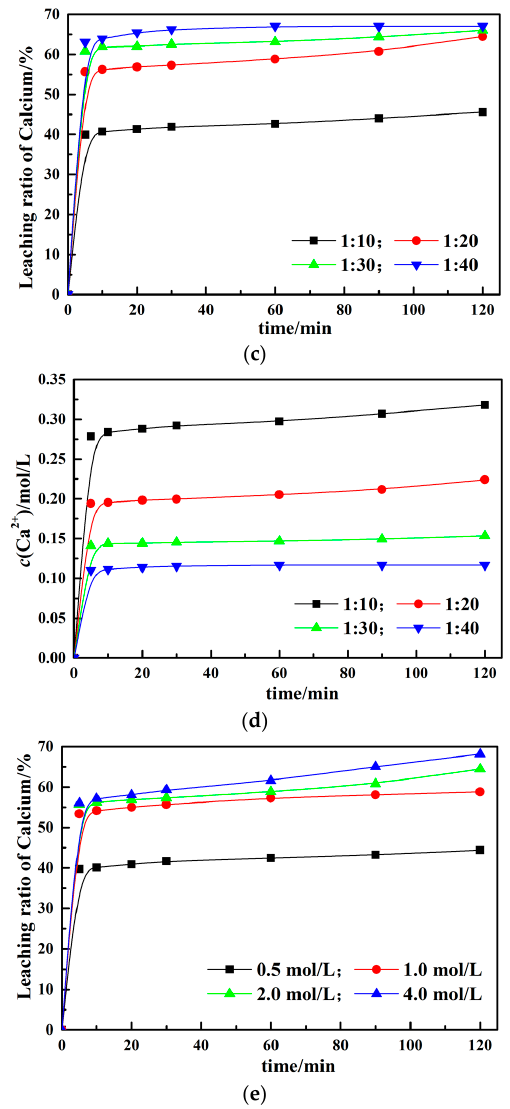
Figure 6. Effect of different technological parameters on calcium leaching: ( a ) the stirring speeds; ( b ) the volume of leaching solution; ( c , d ) the liquid-solid ratio; ( e ) the leaching solution concentration.